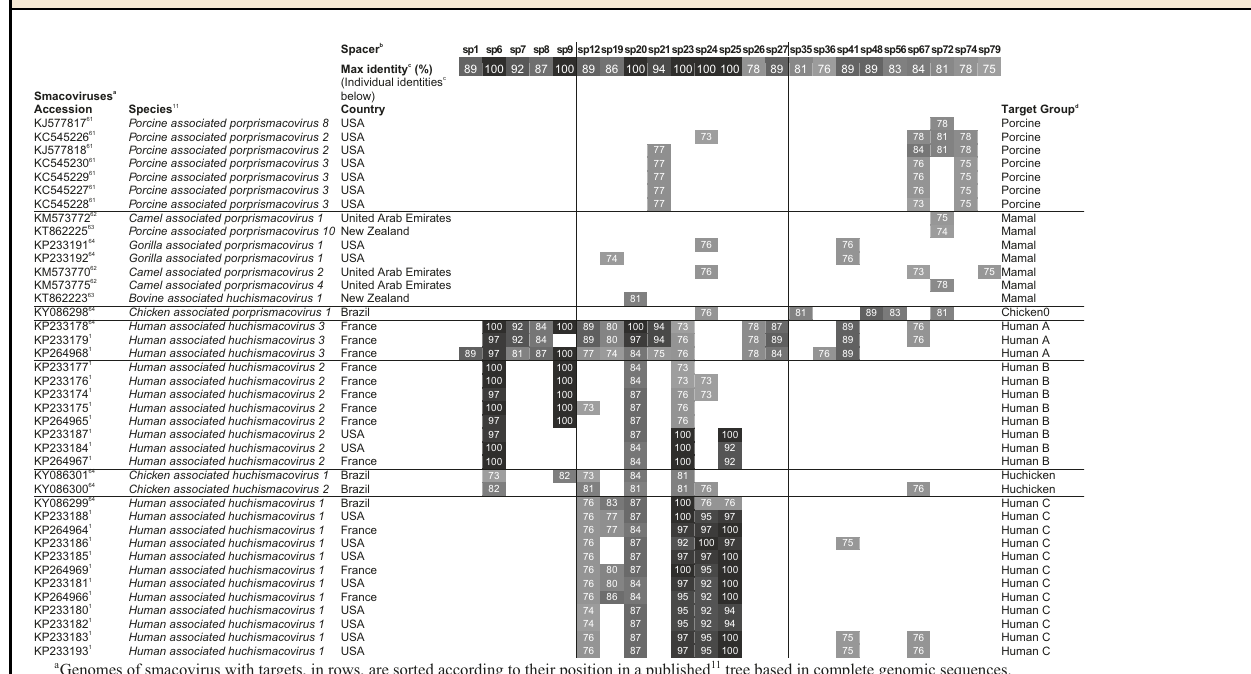
a Genomes of smacovirus with targets, in rows, are sorted according to their position in a published 11 tree based in complete genomic sequences. b Spacers with relevant matches. Vertical lines divides them in tree groups depending on their distance from the leader sequence (see section 'Groups of putatively targeted smacoviruses' in Results for details). c Identity represents alignments of the whole spacer sequence to targets. Identities are highlighted in a greyscale according to their numbers, representing darker tones a higher value. d We defined groups of genomes (target groups) according to their closeness and target profile. Horizontal dashed lines highlight the separation of the groups